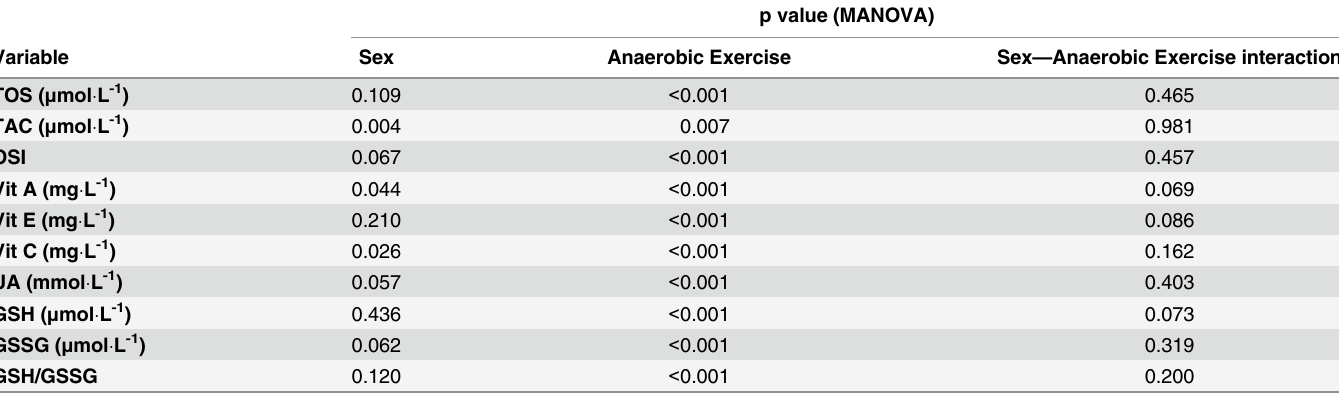
Table 3. Effect of sex, exercise or the sex-anaerobic exercise interaction on biochemical indicators of oxidative stress.